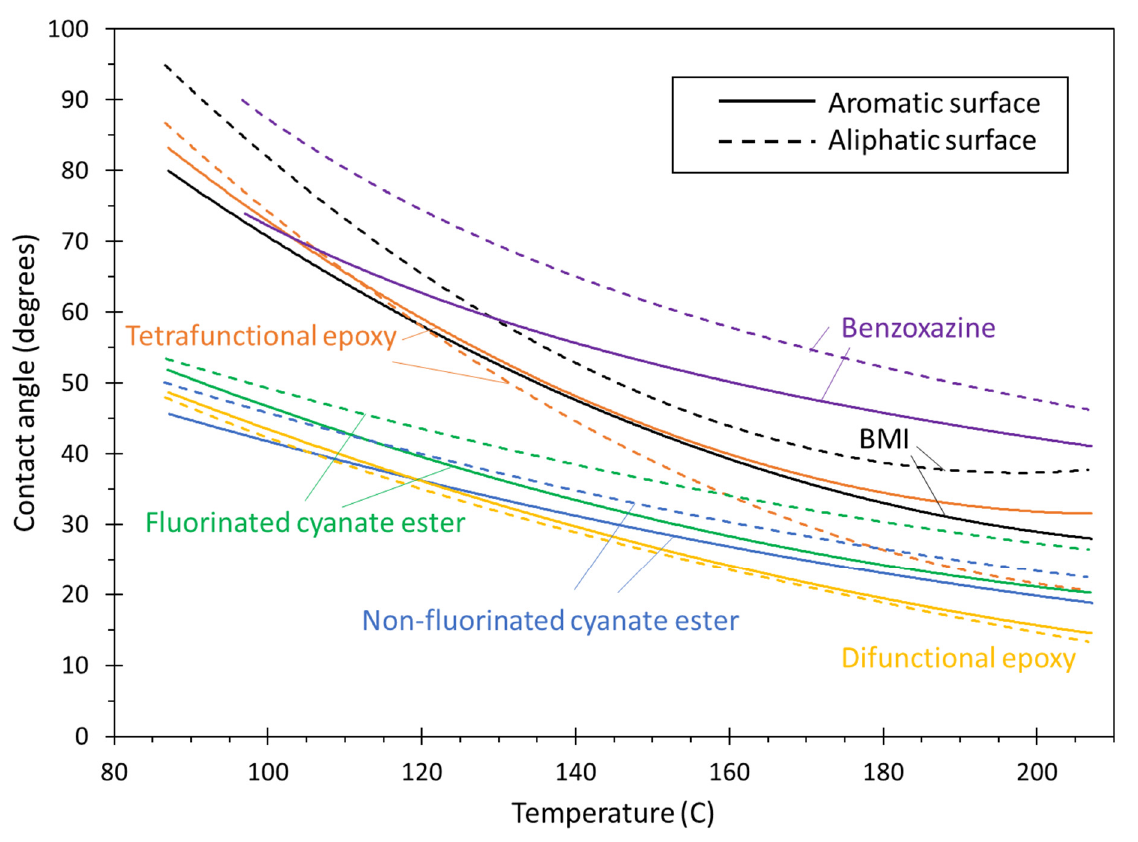
Figure 24. Plot of contact angle vs. temperature of thermosets on both surfaces. The lines are curves fit to the data, and individual averages and error bars have been removed for clarity.